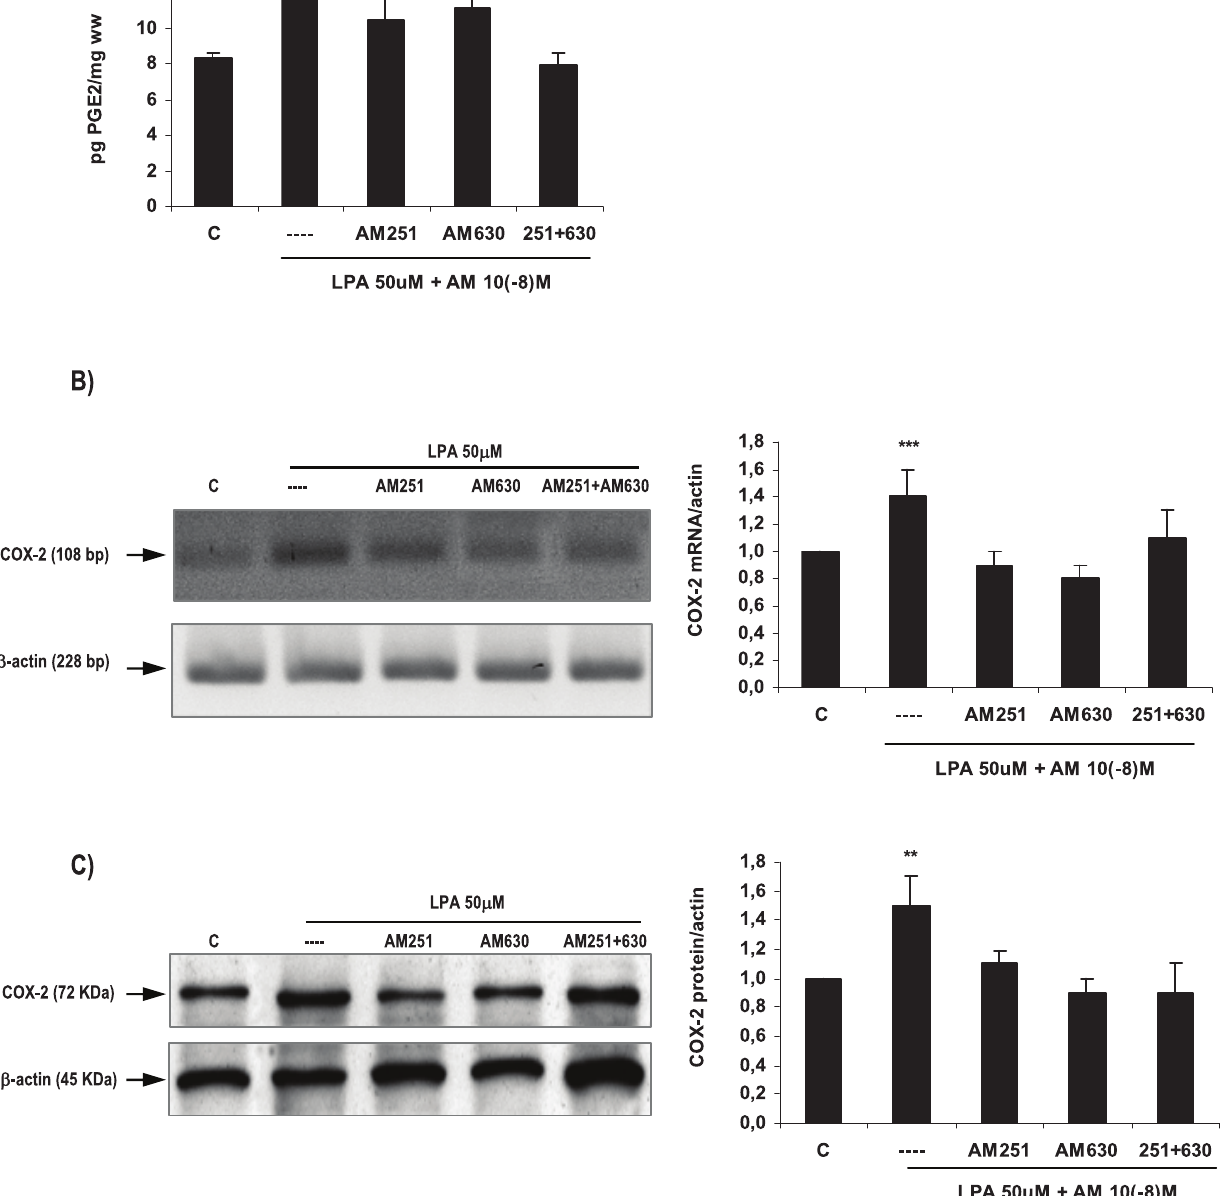
Figure 7. Endocannabinoids mediated LPA effect on the production of PGE2 and on COX-2 expression in the rat uterus during the window of implantation. Uterine strips from rats pregnant on day 5 of gestation (implantation window) were incubated with LPA 50 m M for 6 h in the presence of AM251 10 2 8 M (a selective CB1 antagonist) or AM630 10 2 8 M (a selective CB2 antagonist) or both. The production of PGE2 (A) and the expression of COX-2 mRNA (B) and protein (C) were determined. In A: *** p , 0,001 vs C and 251 + 630; In B: *** p , 0,001 vs the rest; In C: ** p , 0,01 vs the rest. Results are shown as means 6 sem. N=4–6 for each point. C: control.